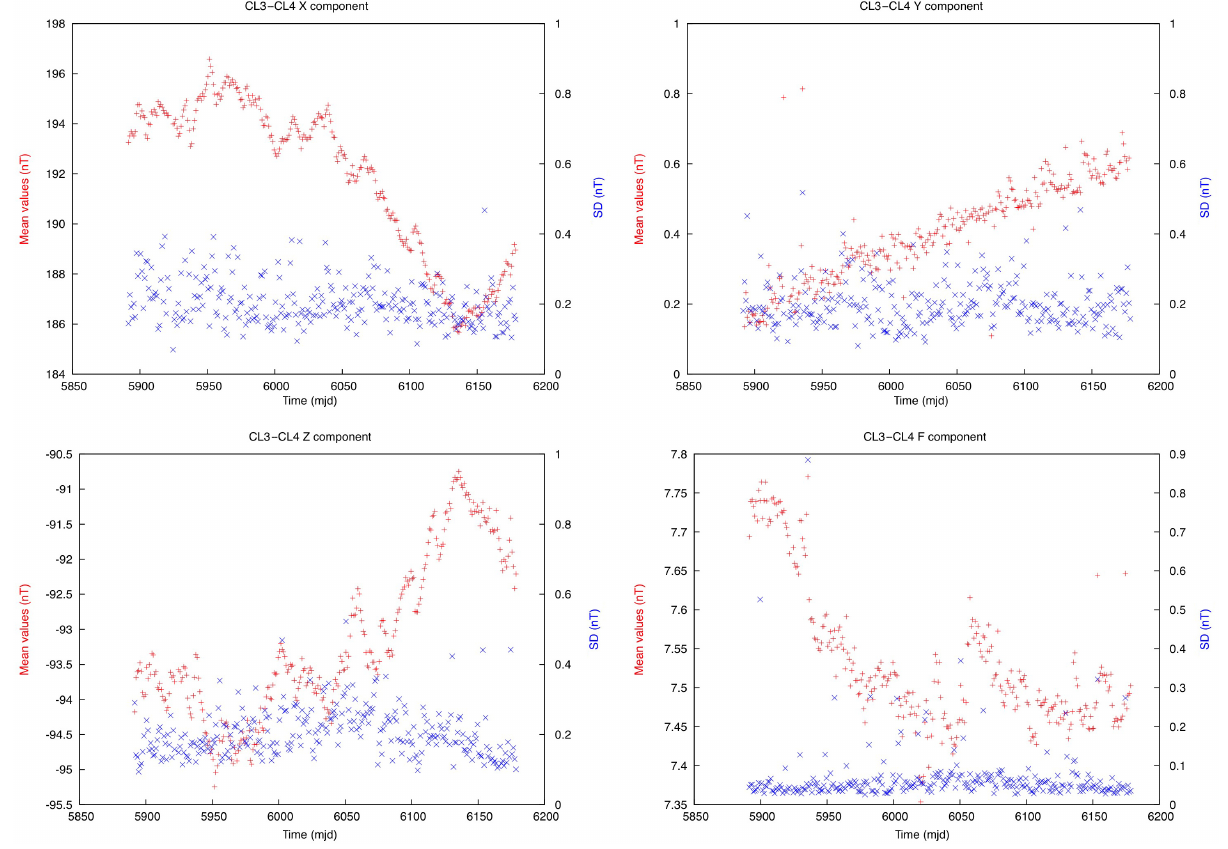
Figure 3. Mean differences (in red) and SDs (in blue) of the three components of CL3 and CL4 variometers and associated scalar instruments for year 2016. The red crosses can be seen as the cumulated baseline values of the CL3 and CL4